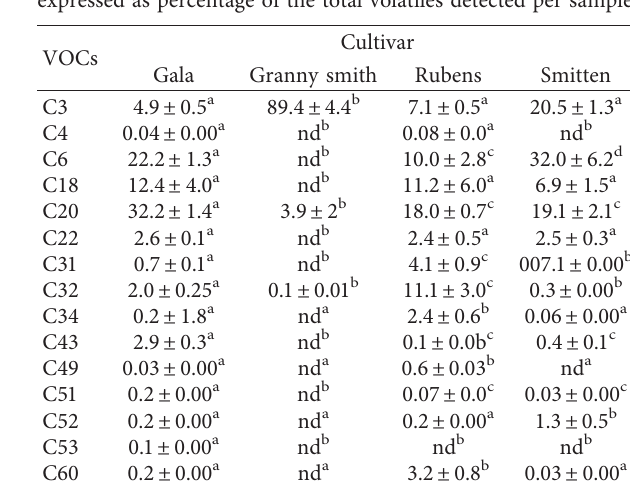
nd � not detected. Superscript letters in the same row indicate differing levels of significance for each respective cultivar (ANOVA Tukey’s HSD test; P ≤ 0 .